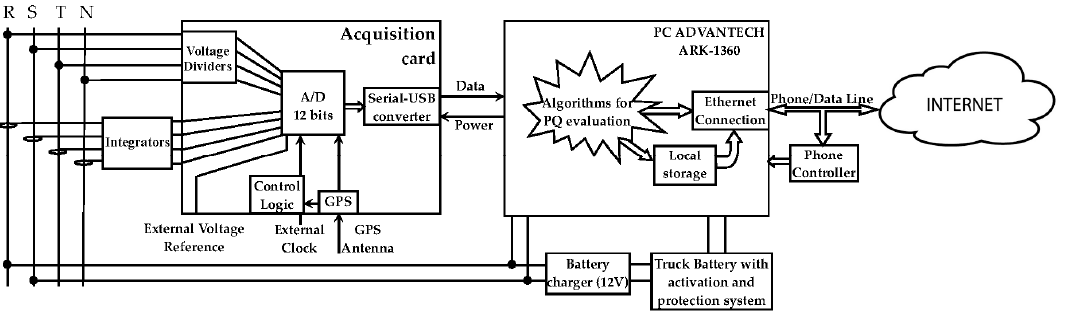
Figure 3. Block scheme of the last architecture of the PQ instrument.